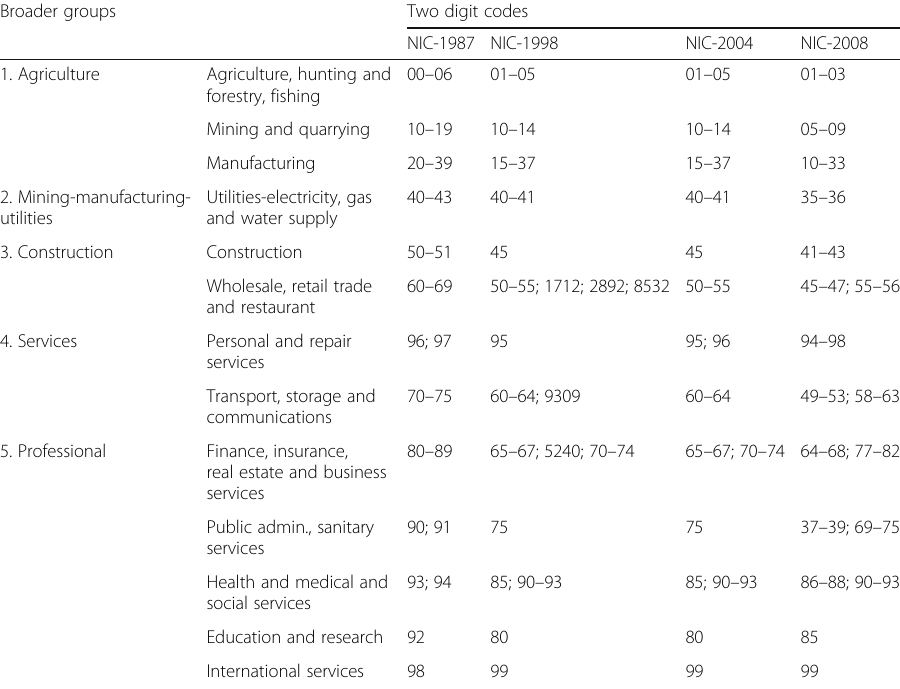
Table 4 Harmonization of industry classification across rounds Broader